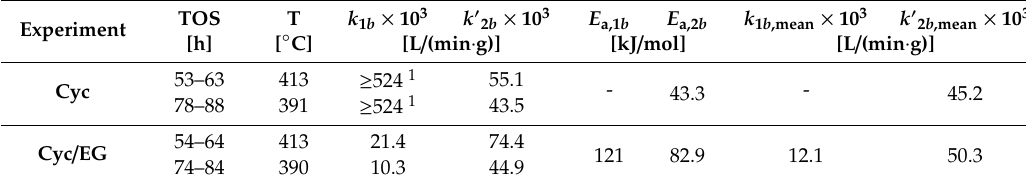
Table 3. First order rate constants as a function of reaction temperature, and apparent activation energies and rate constants at the mean temperature of 395 °C for the conversion of cyclohexanol (reactions 1 b and 2 b ) as pure compound and in mixture with ethylene glycol. For macro-kinetic model, see Section